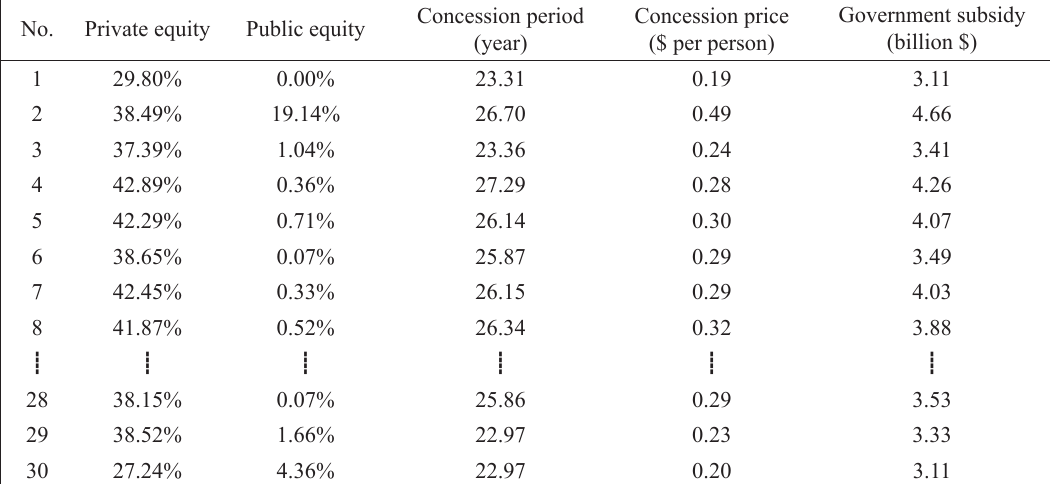
Table 5. Model results: feasible combination of key concessionary